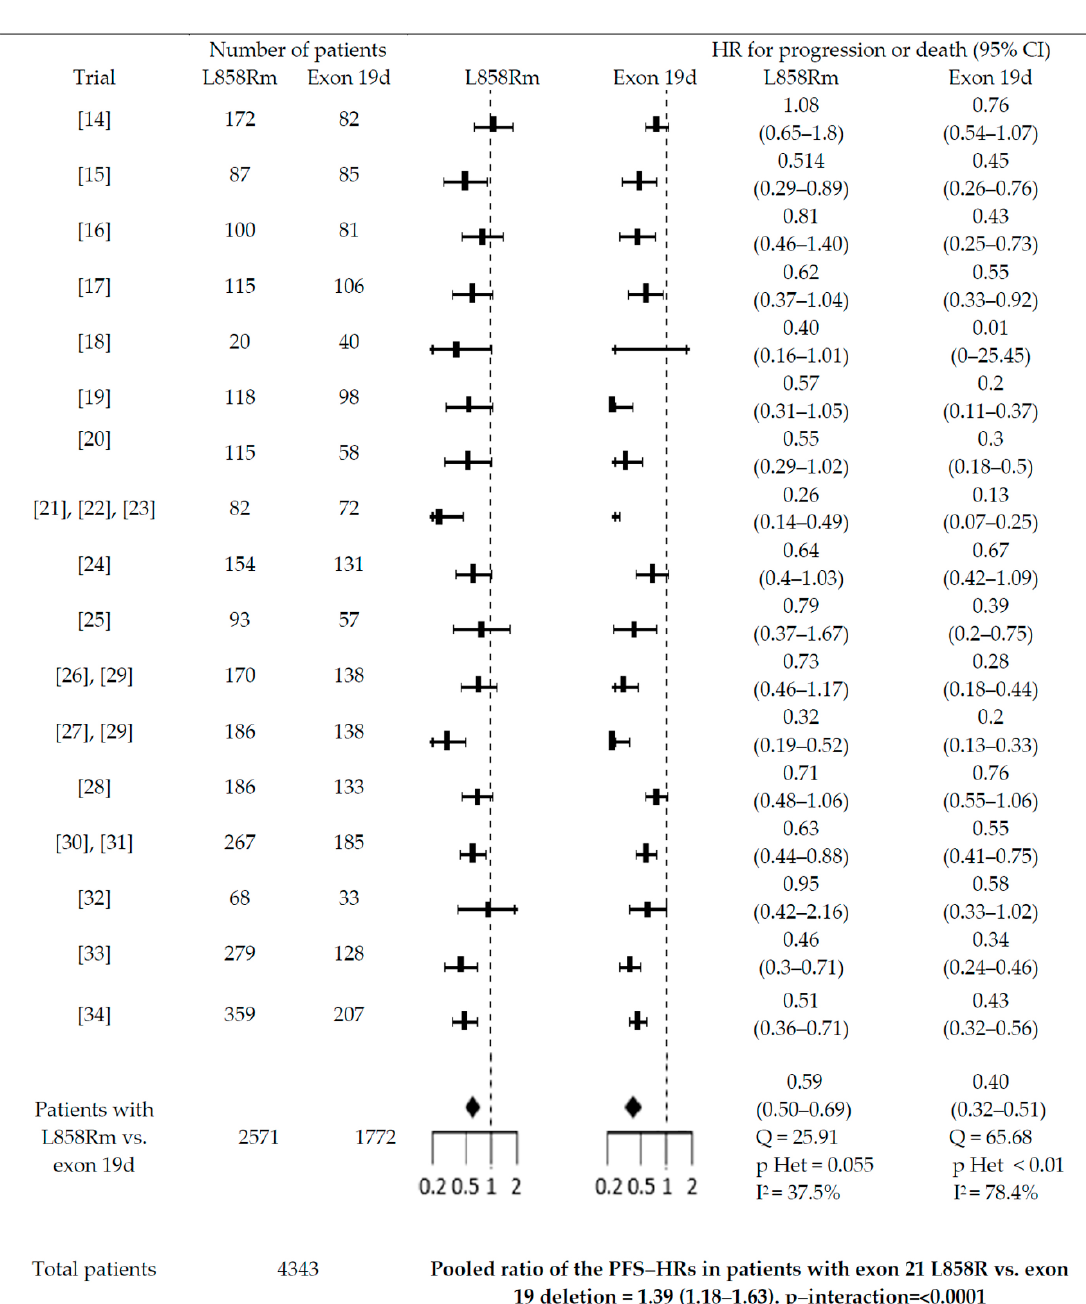
Figure 4. Interaction between PFS-HR and EGFR mutation. PFS-HRs are separately reported for patients with exon 21 L858R mutation vs. exon 19 deletion. Pooled PFS-HRs in patients with exon 21 L858R mutation vs. exon 19 deletion and pooled ratio of the PFS-HRs in patients with exon 21 L858R mutation vs. exon 19 deletion are reported at the bottom of the figure. m = mutation; d = deletion.